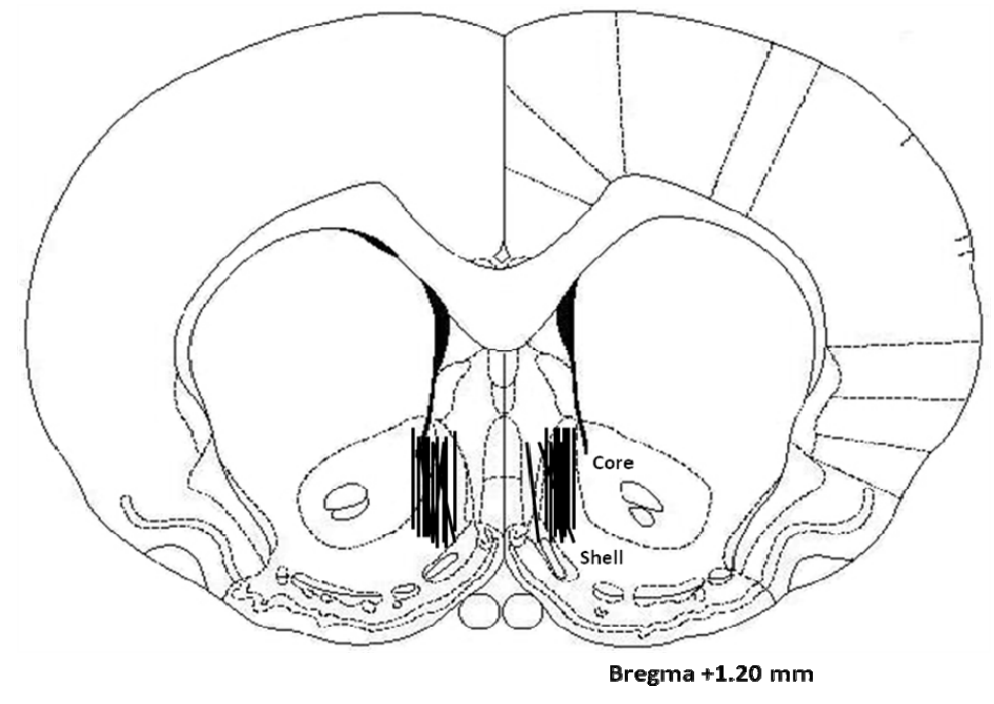
Figure 3. Microdialysis probes were located in the medial NAc